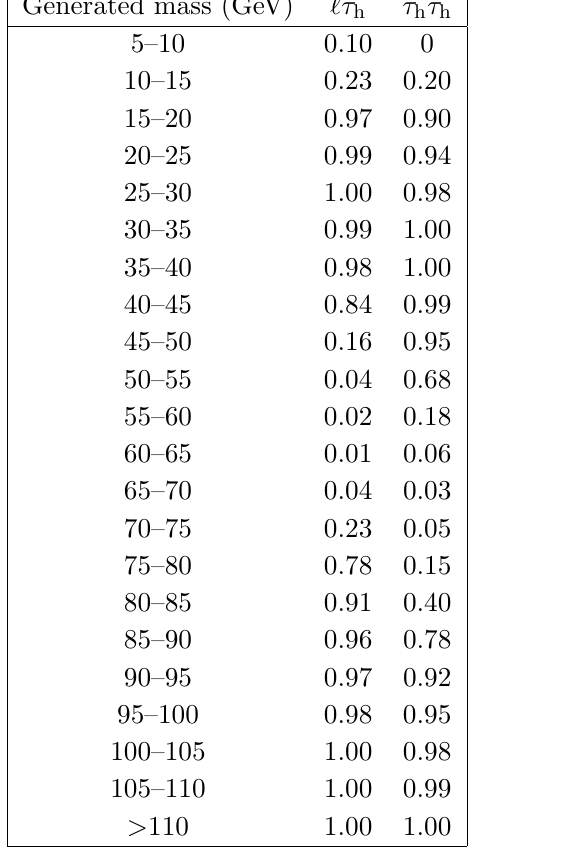
Table 10 . E(cid:14)ciencies of the invariant mass requirements in di(cid:11)erent channels versus gener- ated mass.